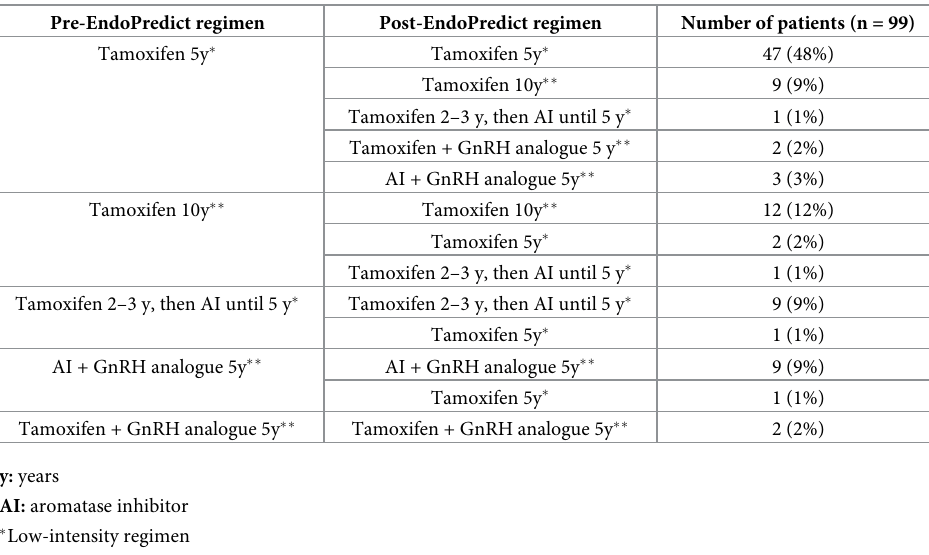
Table 6. Pre- and post-EndoPredict endocrine therapy regimens.